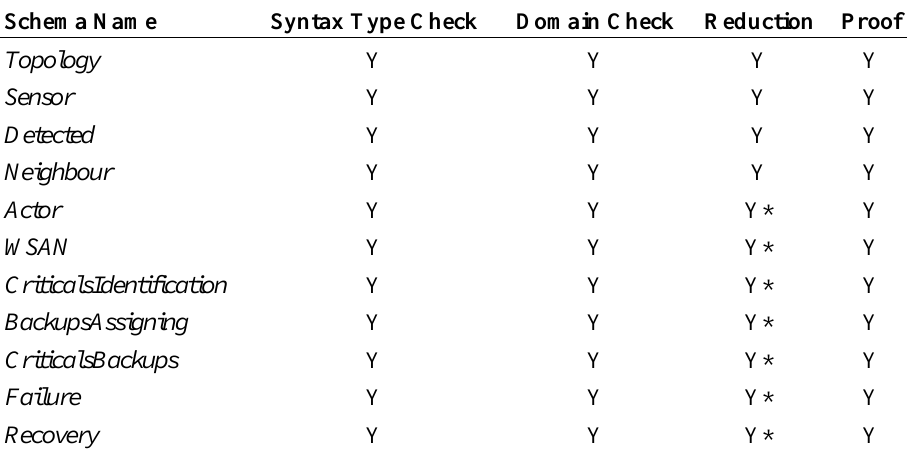
Table 1. Results of model